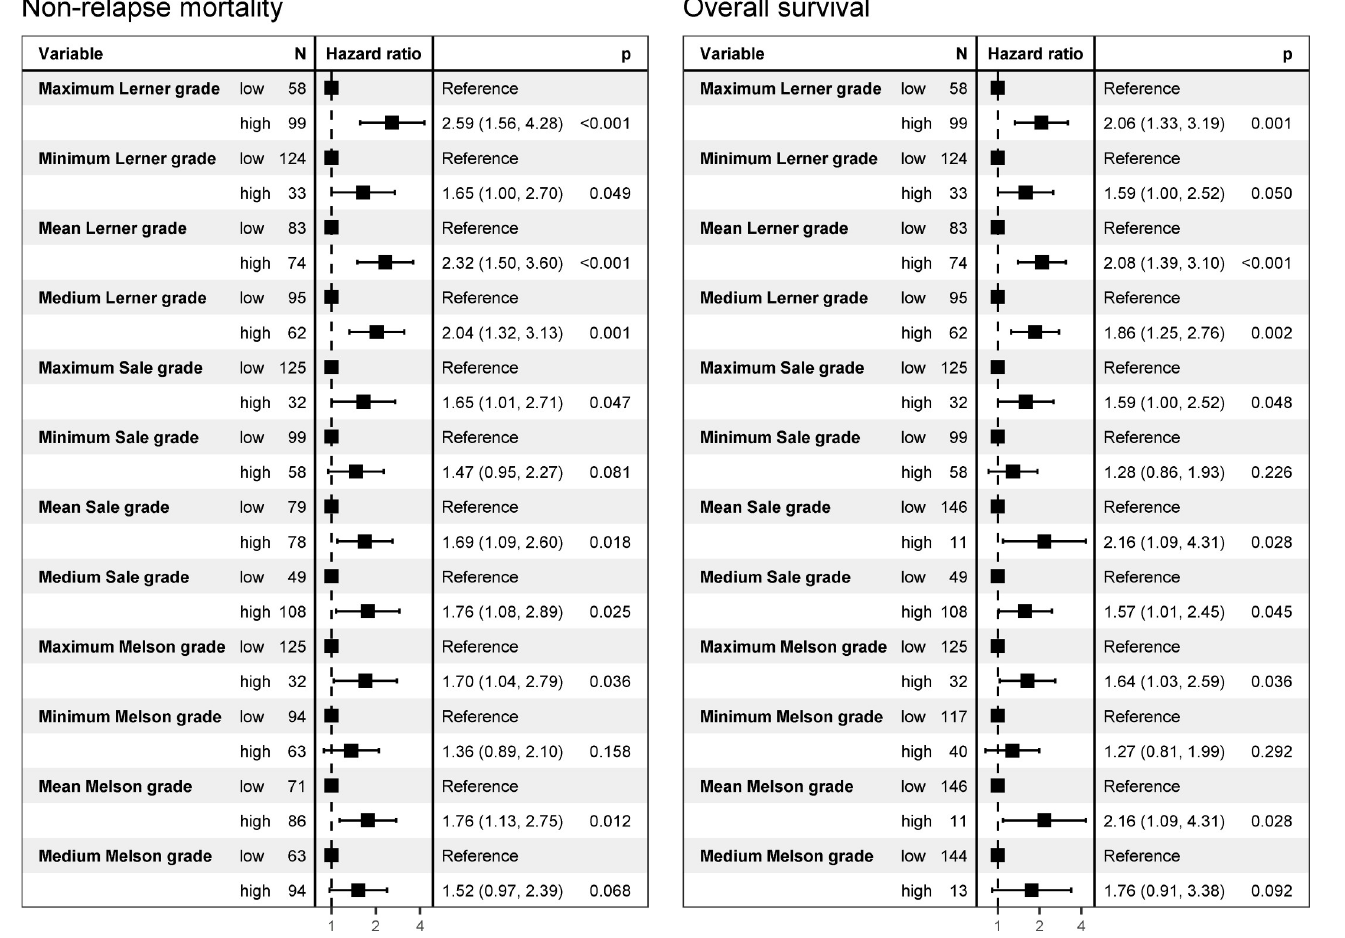
Fig 6. Univariate Cox regression analysis of non-relapse mortality and overall survival on histological grades.